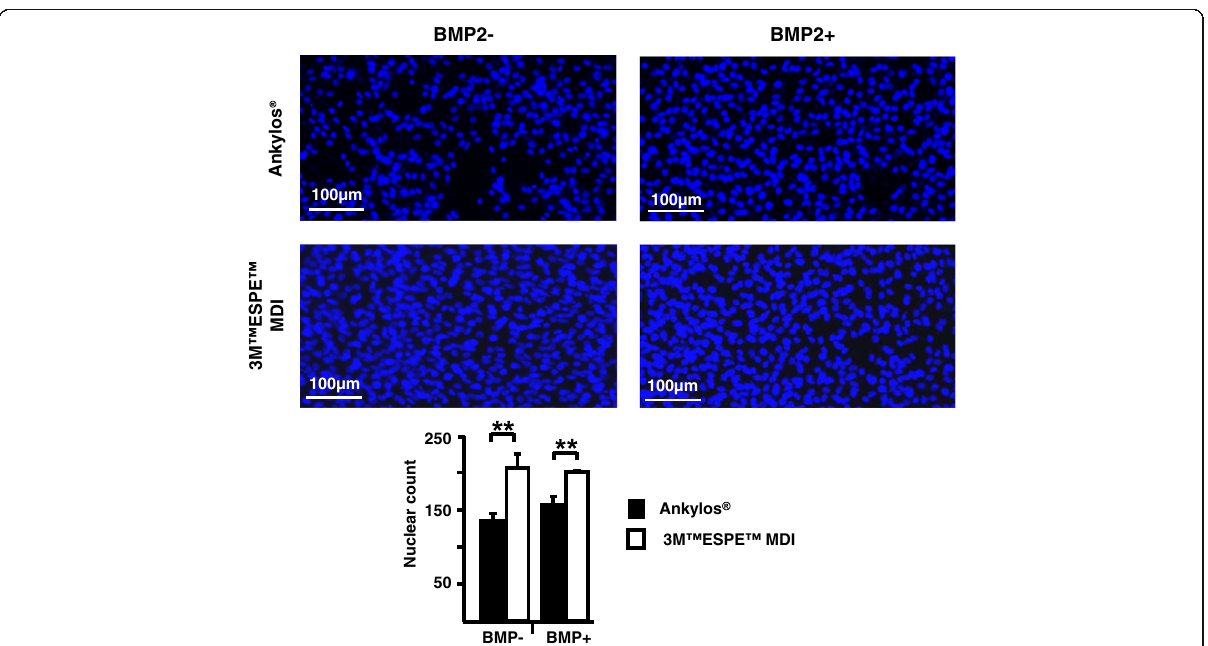
Fig. 3 Increased proliferation of C2C12 cells grown on 3M ™ ESPE ™ MDI disks in comparison to the cells grown on the Ankylos® disks untreated and treated with bone morphogenetic